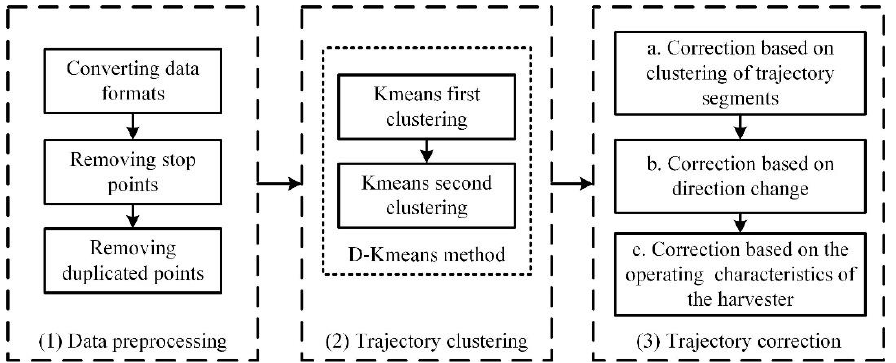
Figure 2. Flowchart of wheat harvester’s trajectory identification based on K-means algorithm. a. The first correction can improve the trajectory identifying accuracy of D-K-Means; b. The second correction can identify abnormal working trajectories; c. The third correction can define the begin and end positions of the turning.